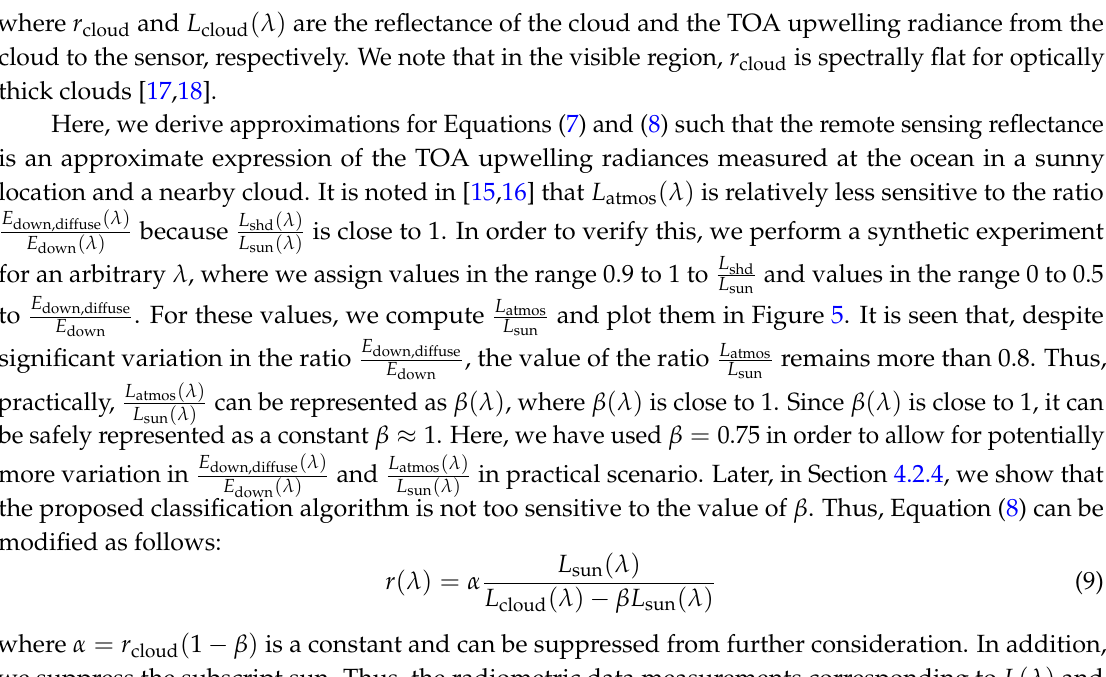
is plotted as a function of L shd L sun